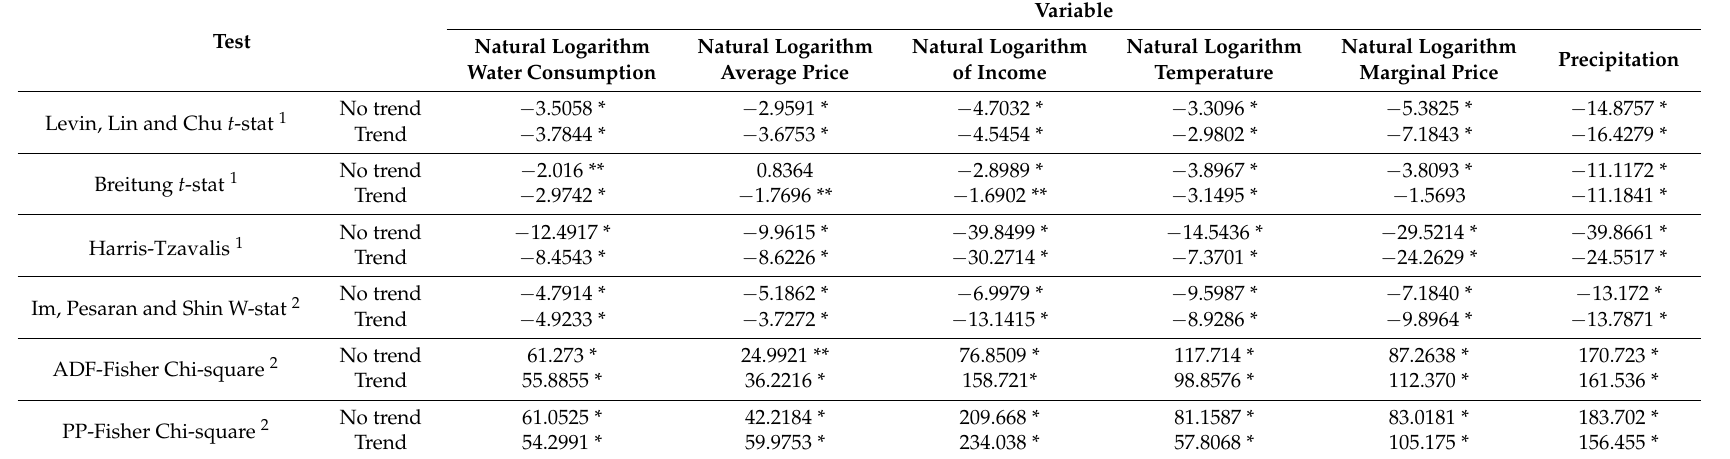
Table 3. Results of unit root tests of the dynamic function variables.